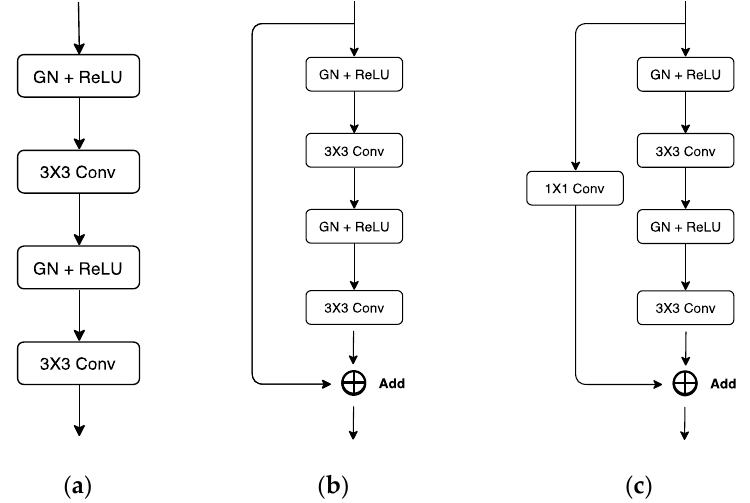
Figure 5. Building blocks of the ResUNet: ( a ) CONV; ( b ) Res; ( c ) Res-Down / Res-Down-C. For all subfigures shown above, GN / ReLU stands for Group Normalization / Rectified Linear Unit. In addition, CONV and Res were both used for feature extraction, where the latter improved information flow further by adding an extra skip-connection. Res-Down / Res-Down-C was used not only for feature extraction but also for data downsampling, where downsampling was achieved in the dimension of width and height (for Res-Down) or channel (for Res-Down-C). We set strides to 1 for the 1 × 1 Conv and the first 3 × 3 Conv in Res-Down. For all other convolutional layers, strides were set to 1. Table 1. The architecture of a 31-layer ResUNet.